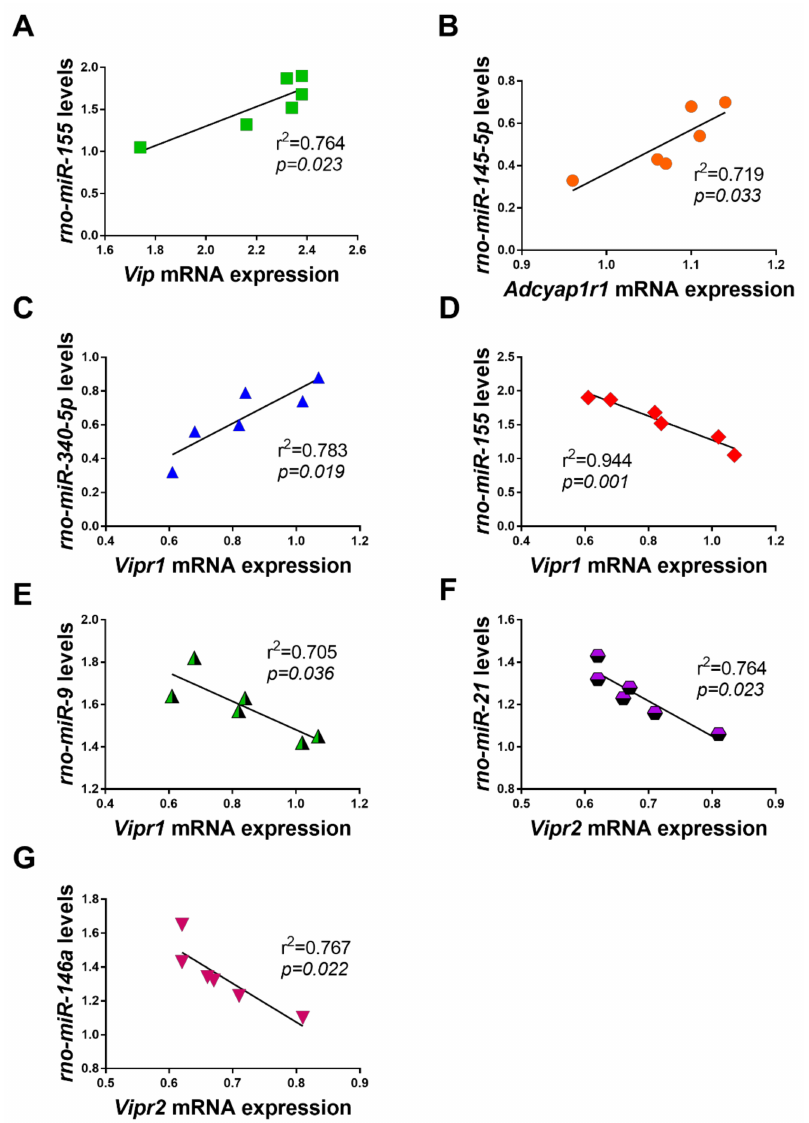
Figure 7. Scatterplots and regression lines showing the relationship between dysregulated miRNAs and the expression profile of VIP/PACAP system components following exposure to LPS. Only significant correlations are shown. Positive correlations were found between ( A ) rno-miR-155 and Vip ; ( B ) rno-miR-145-5p and Adcyap1r1 and ( C ) rno-miR-340-5p and Vipr1 mRNAs. Inverse relationships were found between ( D ) rno-miR-155 and Vipr1 ; ( E ) rno-miR-29a and Vipr1 ; ( F ) rno-miR-21 and Vipr2 and ( G ) rno-miR-146a and Vipr2 . Coefficients of determination ( r 2 ) and related p values are shown in each